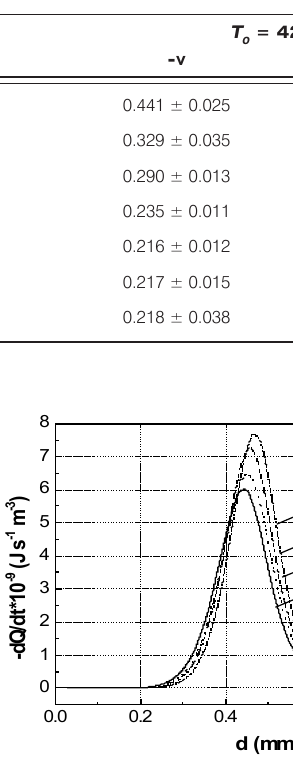
Figure 13. Pressure influence on end flame temperature and mass fractions of several intermediates in the flame front of a stoichiometric C T